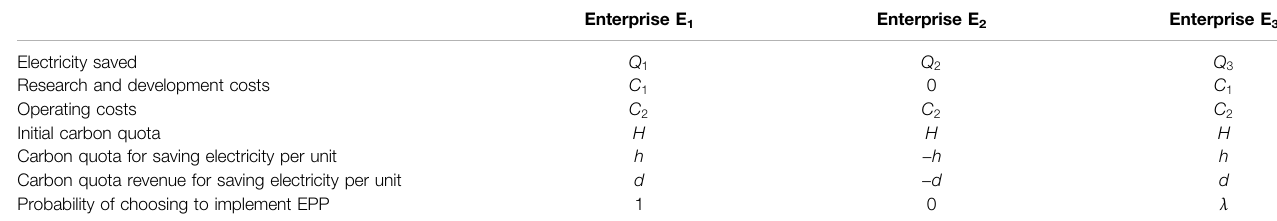
TABLE 2 | Variables and meanings in the assumptions.